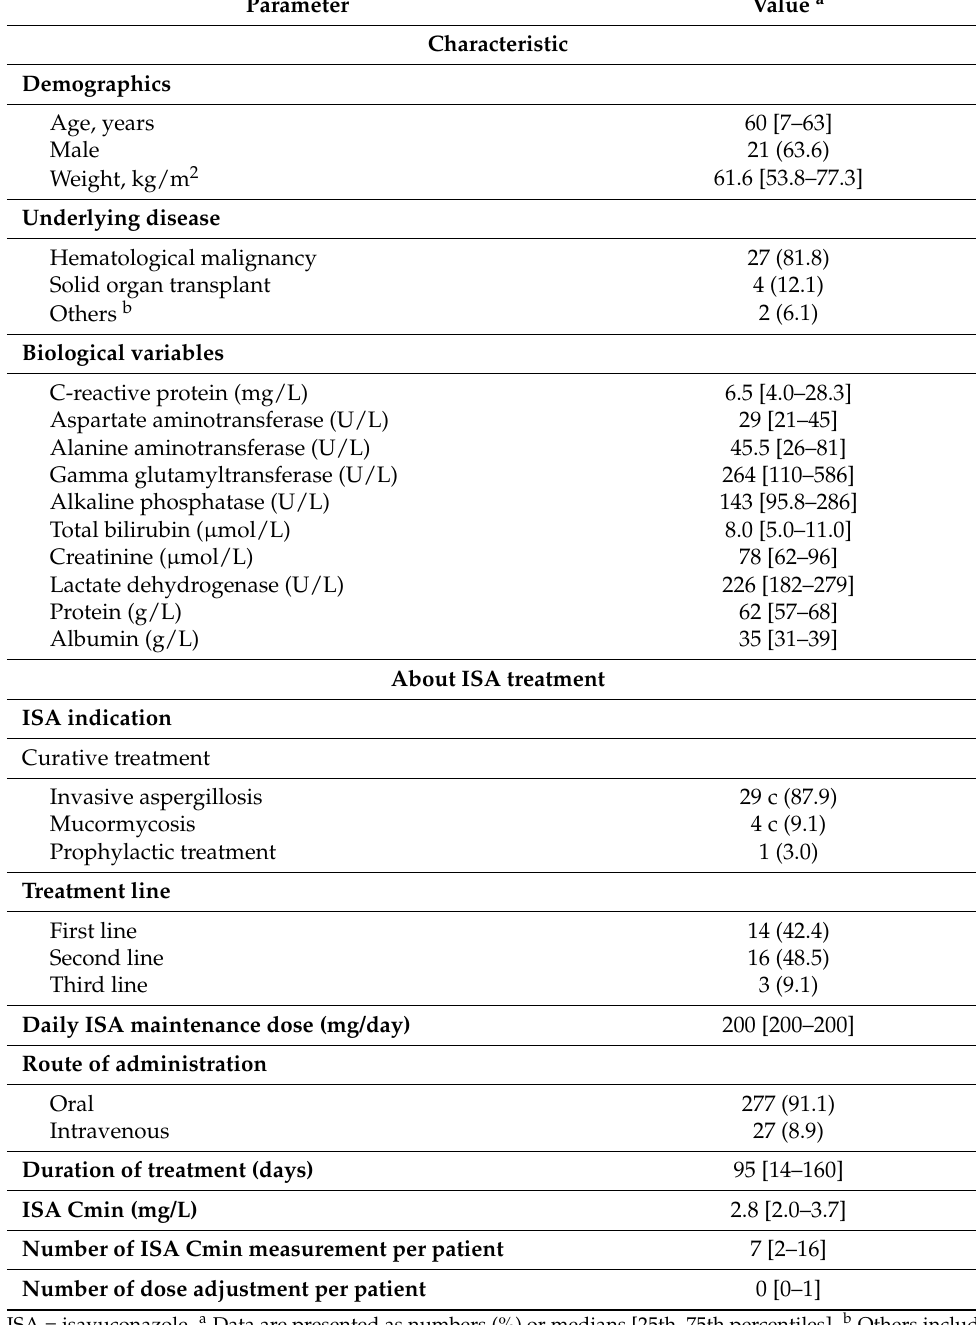
Table 1. Patient